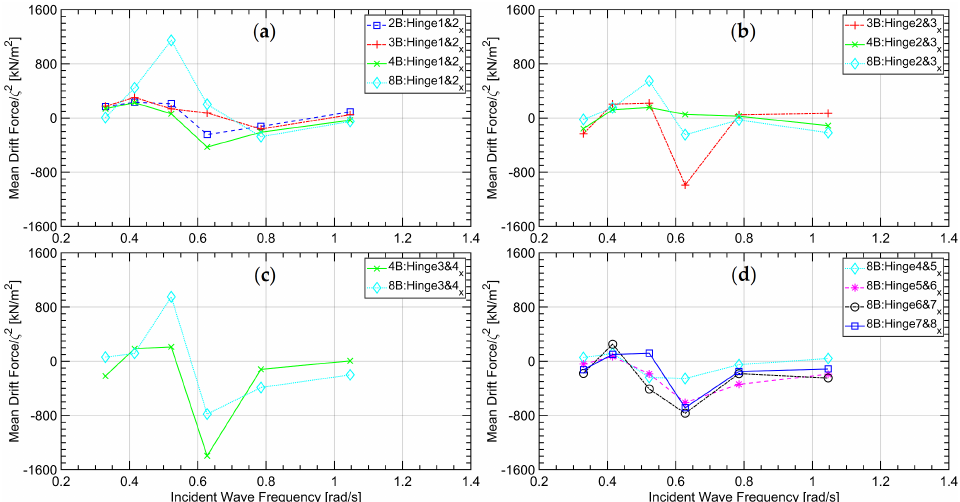
Figure 14. Second-order mean hinge forces in horizontal direction of the five test cases for the chain configuration, where n B denotes the configuration with n bodies; m & n , the hinge connecting m -th body and n -th body; subscript x , the hinged forces in x direction: ( a ) between 1st and 2nd modules; ( b ) between 2nd and 3rd modules; ( c ) between 3rd and 4th modules; ( d ) between 4th and 5th , 5th and 6th , 6th and 7th , 7th and 8th